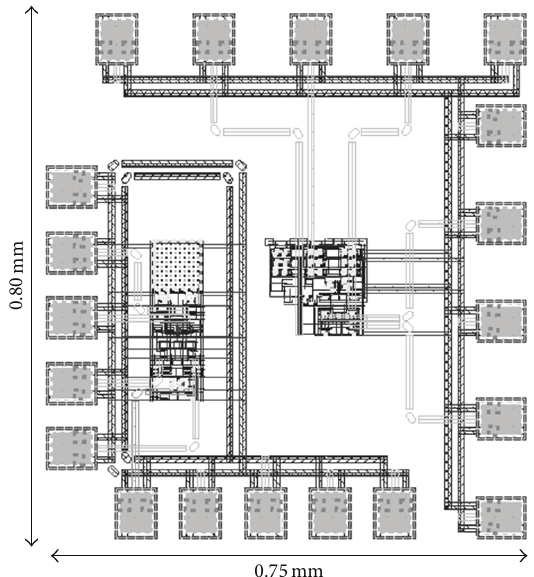
Figure 4: Layout of the proposed